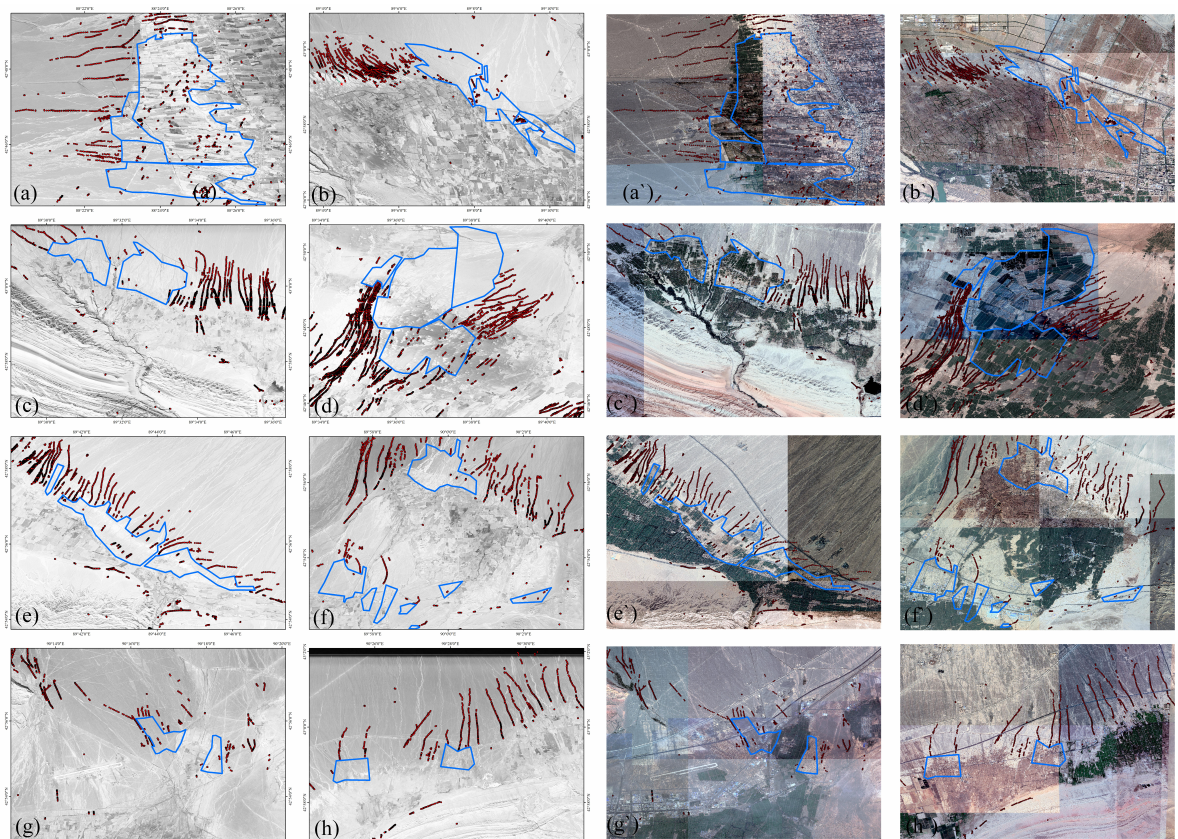
Figure 14. The red dots show the karez shafts in 2020, and the blue polygon shows the area where the karez shafts existed in 1970 but did not exist in 2020. ( a – h , a’ – h’ ) correspond to the eight yellow boxes in Figure 13, respectively. The base maps for ( a – h ) are CORONA imagery, while the base maps for ( a’ – h’ ) are Google imagery from